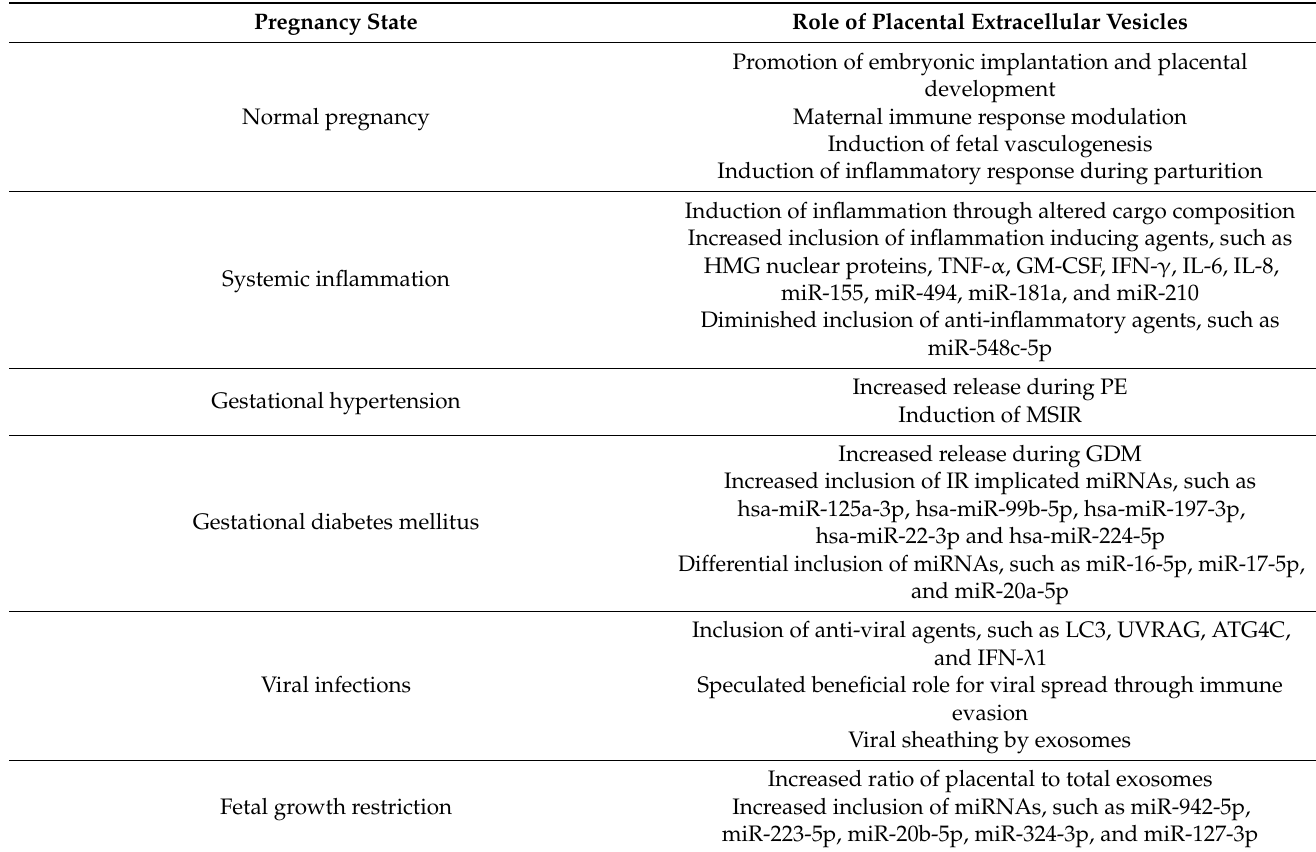
Table 4. Role of placental EVs during different pregnancy